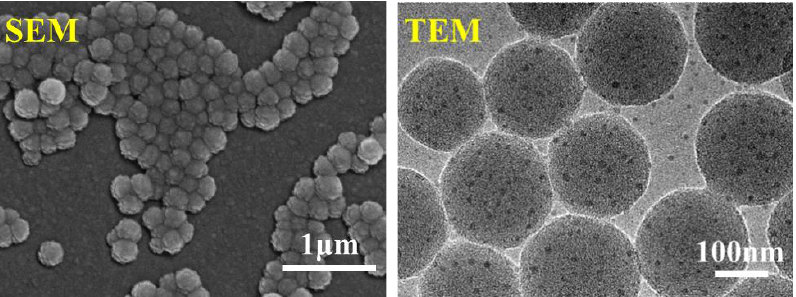
Figure 3. SEM and TEM images of SiO 2 -Def.